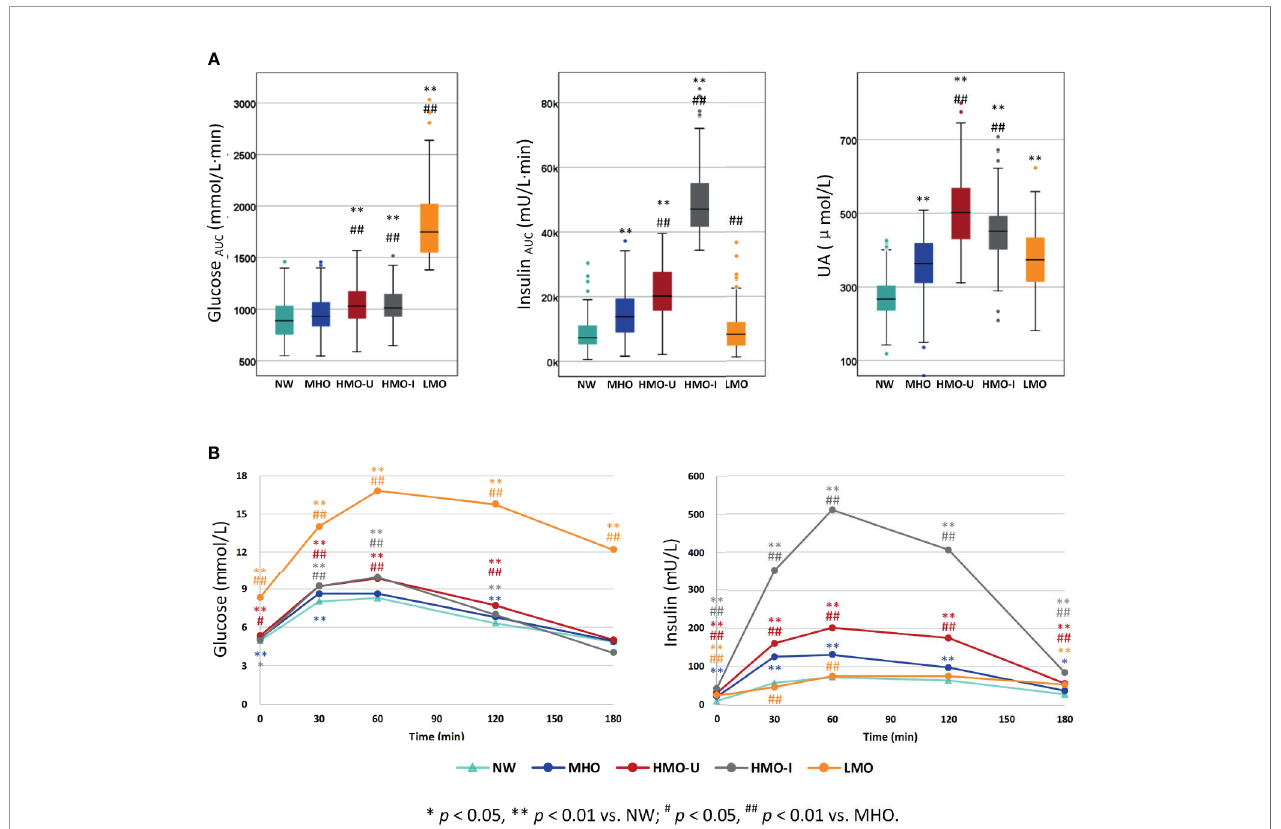
FIGURE 3 | Comparison of the three classi fi cation variables across the four clusters generated from Cohort-1 using k-means. (A) The three classi fi cation variables. (B) Oral glucose tolerance test (OGTT) curves for glucose and insulin. P values refer to results after adjustment for age and sex. HMO-I, hypermetabolic obesity hyperinsulinemia subtype; HMO-U, hypermetabolic obesity hyperuricemia subtype; LMO, hypometabolic obesity; MHO, metabolic healthy obesity; NW, normal- weight control; UA, uric acid.